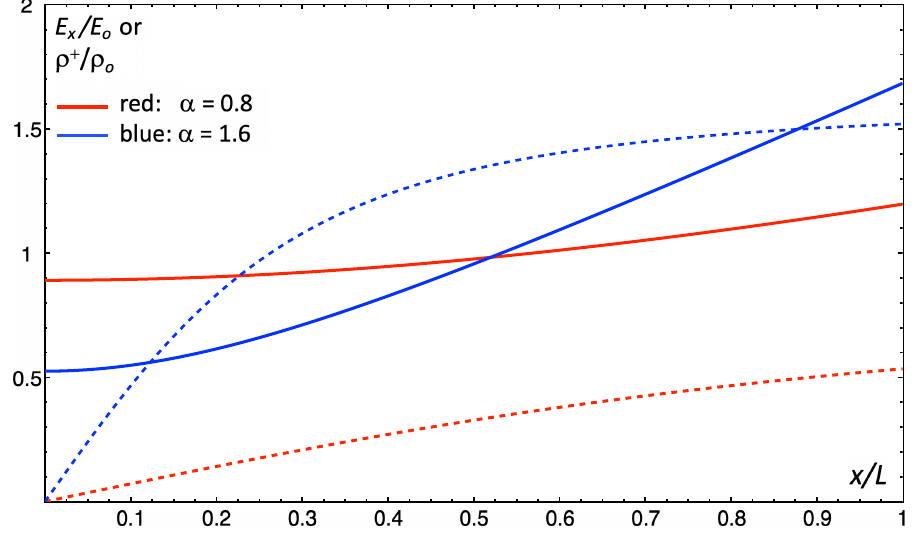
Figure 2. Electric field (continuous lines) and charge density (dashed line) behavior for α = 0.8 (red) and α = 1.6 (blue). The horizontal axis is the drift coordinate divided by the gap length ( x / L ), with x = 0 ( 1 ) at the anode (cathode). The electric field is in units of E ◦ = V ◦ / L , and the charge density in units of ρ ◦ = (cid:101) E ◦ / L . Reproduced from reference